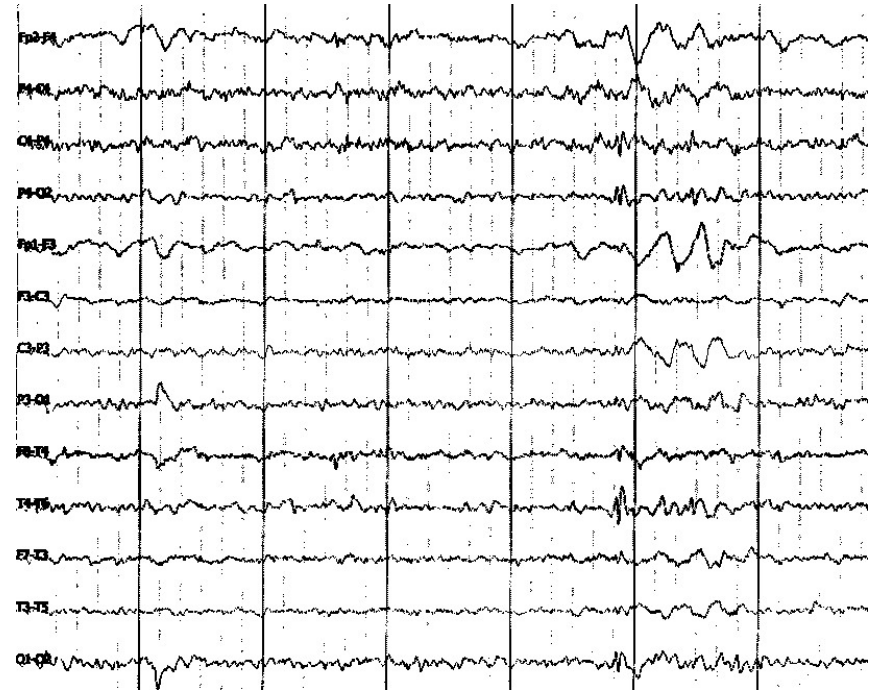
Fig. 1 Interictal electroencephalography (EEG) shows independent focal epileptiform discharges with spikes and sharp waves at the right temporo-parieto-occipital lobe and sharp transients at the left frontal